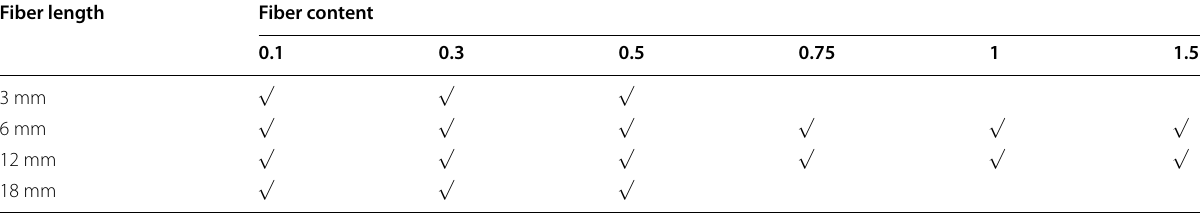
Table 5 Combination of PVA fiber length and